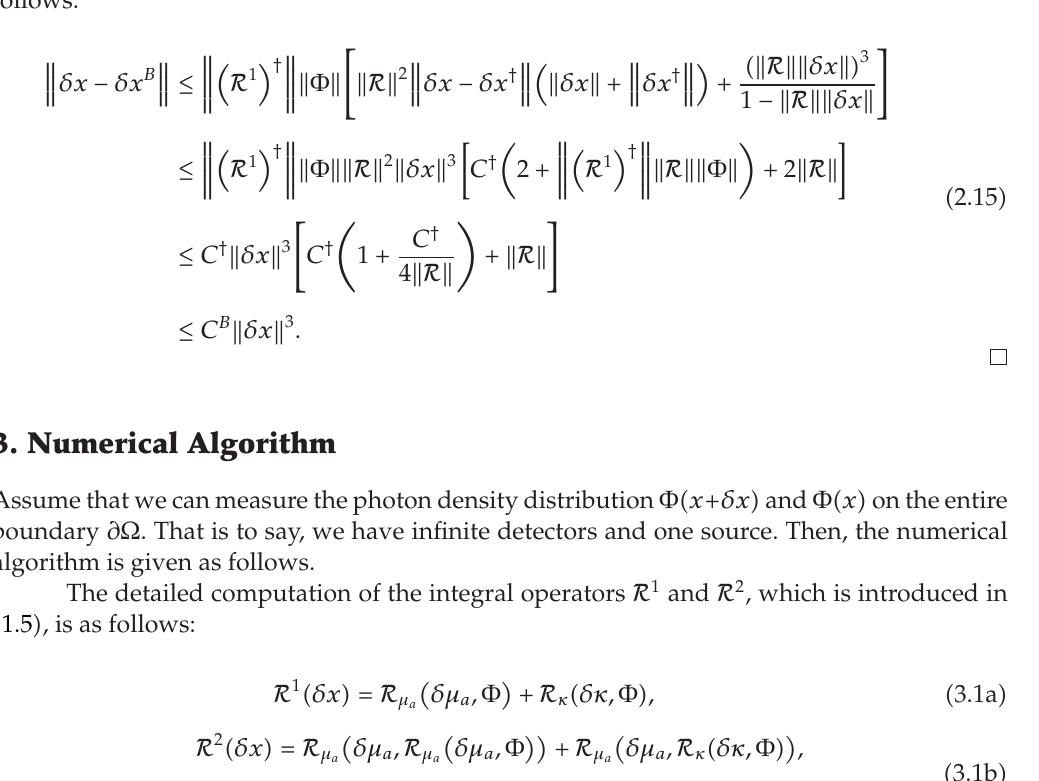
Algorithm 1: Numerical algorithm (cid:6) continuous version (cid:8)